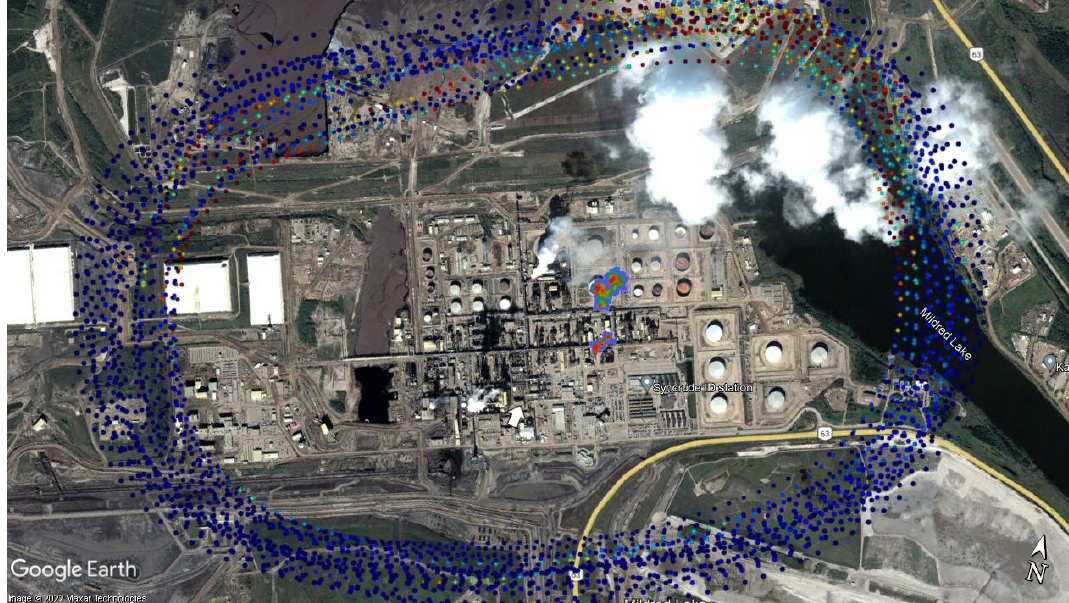
Figure 5. AVIRIS-NG-captured CH 4 column enhancements are shown from 11 August 2017 inside the F04 raw CH 4 lap data around the Syncrude plant from SciAv for 14 August 2017 using the Google Earth historical image from September 2016. AVIRIS-NG data and imagery provided by the NASA-JPL and satellite imagery ©2020 Maxar Technologies, Google Earth. Large CH 4 enhancements are depicted in red. The wind direction is shown by the white arrow, as measured by SciAv. Table 3. Results of the CH 4 (in kilograms per hour) and CO 2 (in tonnes per hour) standard fit estimates from each algorithm, with their uncertainty as a percentage ± % and the range derived from the percentage uncertainty of each standard